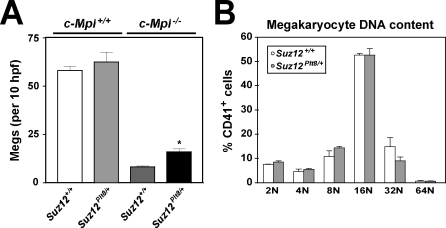
Megakaryocyte Number and DNA Content in PLT8 Mice(A) Megakaryocytes were counted on stained sections of bone marrow (600× magnification). The data represent the average number of megakaryocytes per 10 fields (hpf); 3–16 mice were scored for each genotype. Error bars represent the standard error of the mean and an asterisk has been used to denote statistical significance (*p<0.001).(B) The DNA content of wild-type and mutant megakaryocytes was analysed by flow cytometry using CD41 staining in combination with propidium iodide (Suz12Plt8/+ mice n = 3, and controls n = 4). No statistically significant differences were observed.